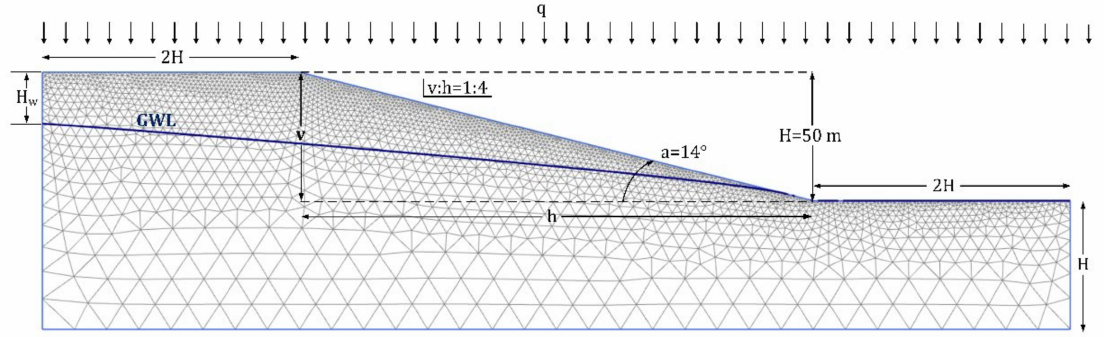
Figure 7. FEM pit slope model’s geometry and hydraulic